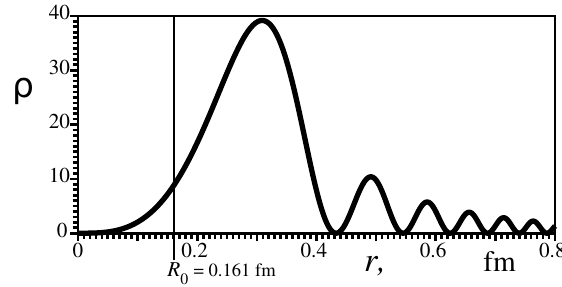
Figure 8. Density distribution function ρ ( r ) versus r